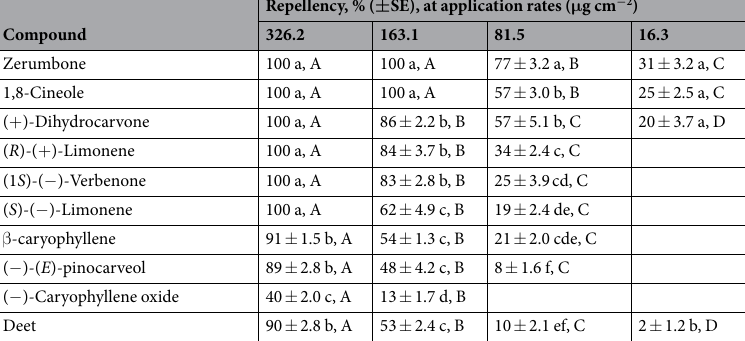
Table 2. Repellency of nine pure organic compounds and a commercial repellent, deet, against male Blattella germanica using a filter-paper choice assay. Means followed by the same lowercase letter in the same column or the same uppercase letter in the same row are not significantly different ( P = 0.05, Bonferroni